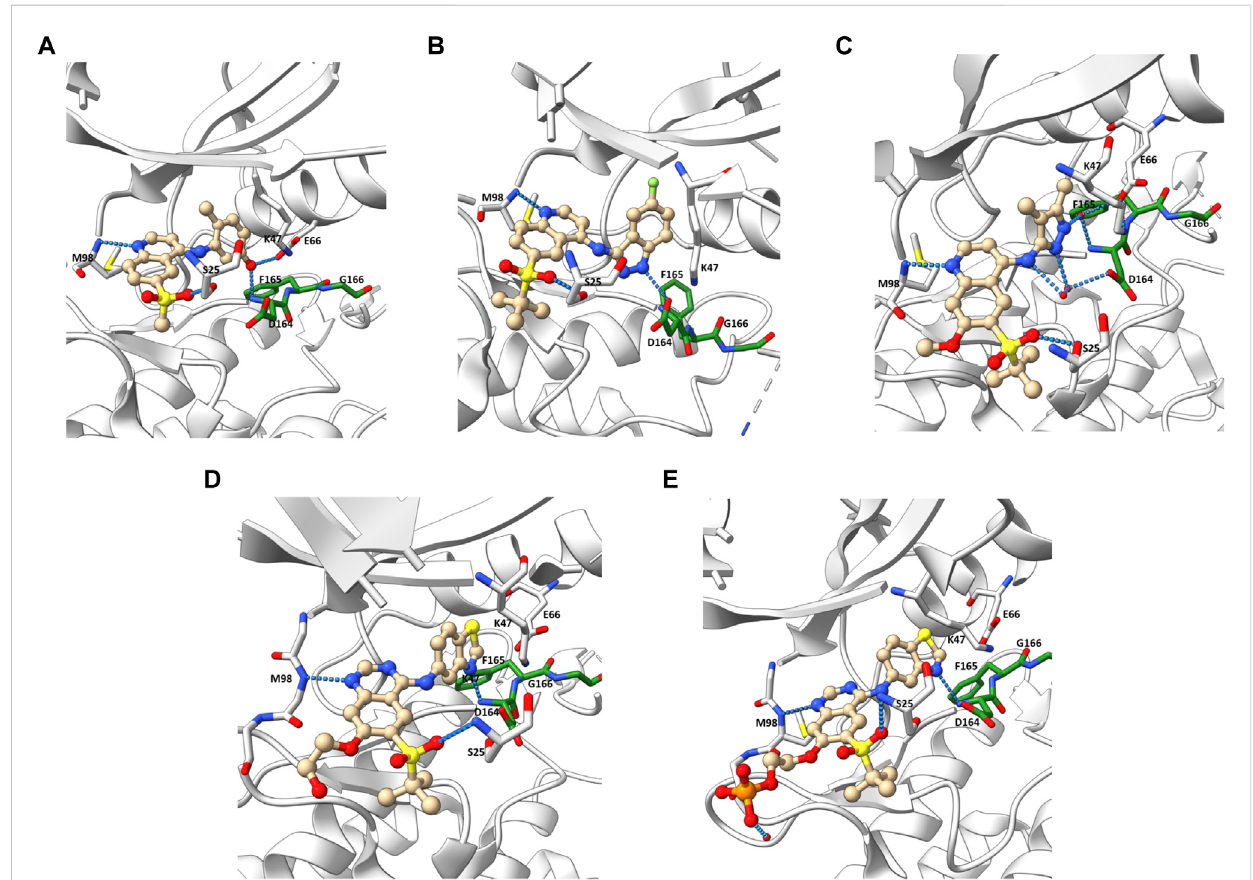
Co-crystal structure of RIPK2 in complex with 2 (PDB ID: 5J79) (A) , GSK583 (PDB ID: 5J7B) (B) , 3 (PDB ID: 6HMX) (C) , 4 (PDB ID: 6RNA) (D) , and GSK2983559 (PDB ID: 6RN8) (E)